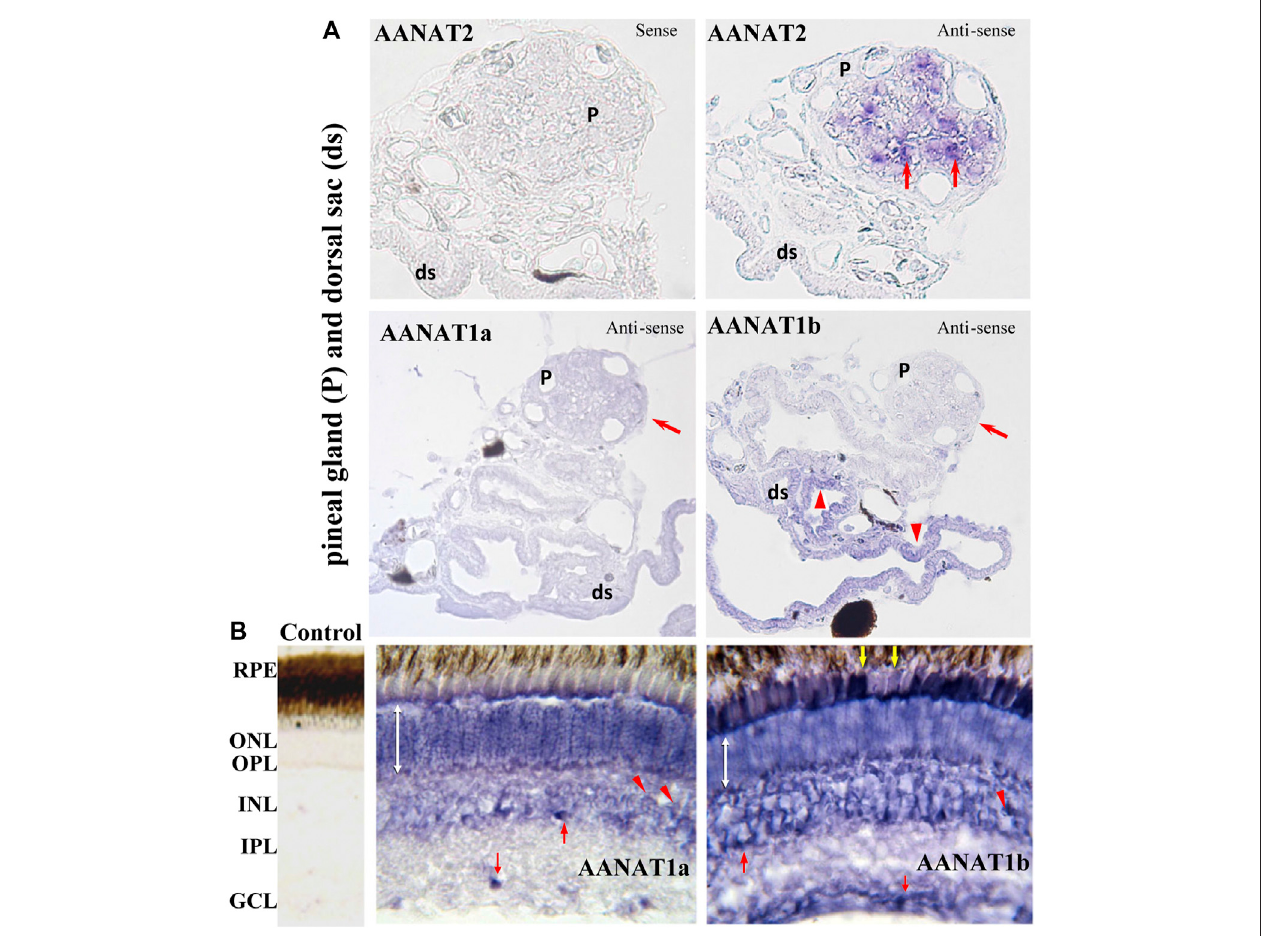
FIGURE 6 | Detection of aanat ( aanat1a , aanat1b, and aanat2 ) transcriptions in fi sh pineal gland (A) and retina (B) (adopted from Paulin et al., 2015). (A) Pinealocytes (arrows) are labeled with the antisense aanat2 probe, but not with either aanat1a or aanat1b probes. Cells of dorsal sac (arrow heads) are stained with aanat1b antisenseprobes but notwith aanat2 probe. ds: dorsalsac; P:pineal gland. (B) Photoreceptor cells oftheONL arestained(double whitearrow). Bipolar (arrow heads) and amacrine (upward red arrow) cells in the INL are also labeled. A few cells are labeled in the GCL (downward red arrow) and RPE (downward yellow arrows).GCL: ganglioncelllayer; INL:inner nuclearlayer;IPL:inner plexiformlayer;ONL:outer nuclearlayer; OPL:outerplexiformlayer;RPE:retinal pigment